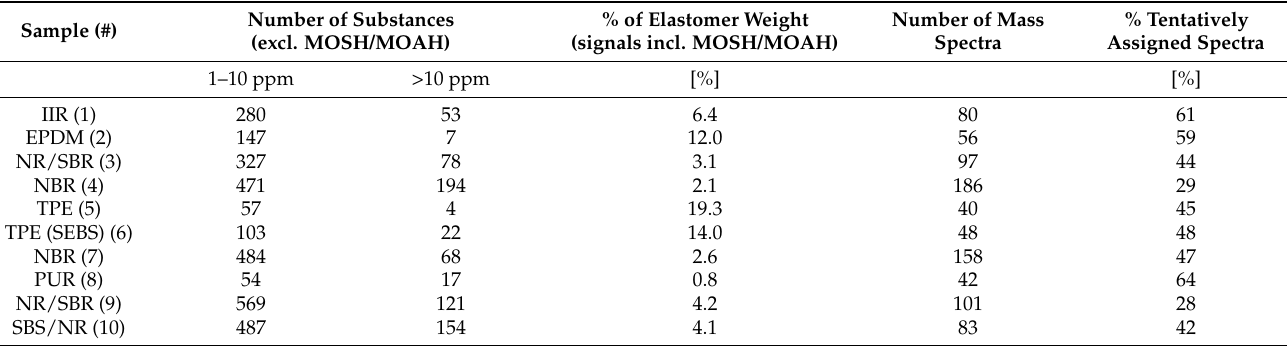
Table 2. Number of substances found in the GC × GC-FID chromatograms and number of spectra obtained by GC × GC-MS.